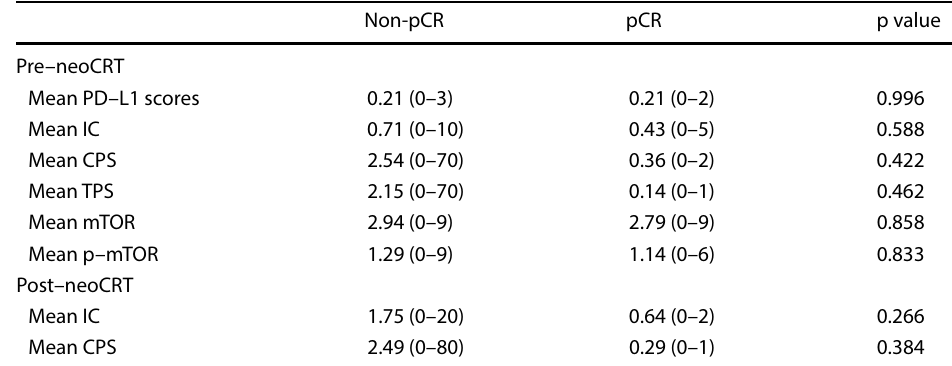
Table 2 mTOR signaling pathway and PD-L1 expression for pCR